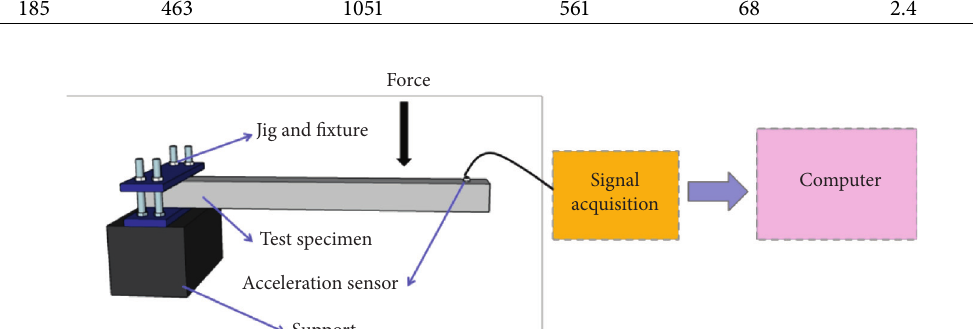
Figure 2: Damping ratio test device.